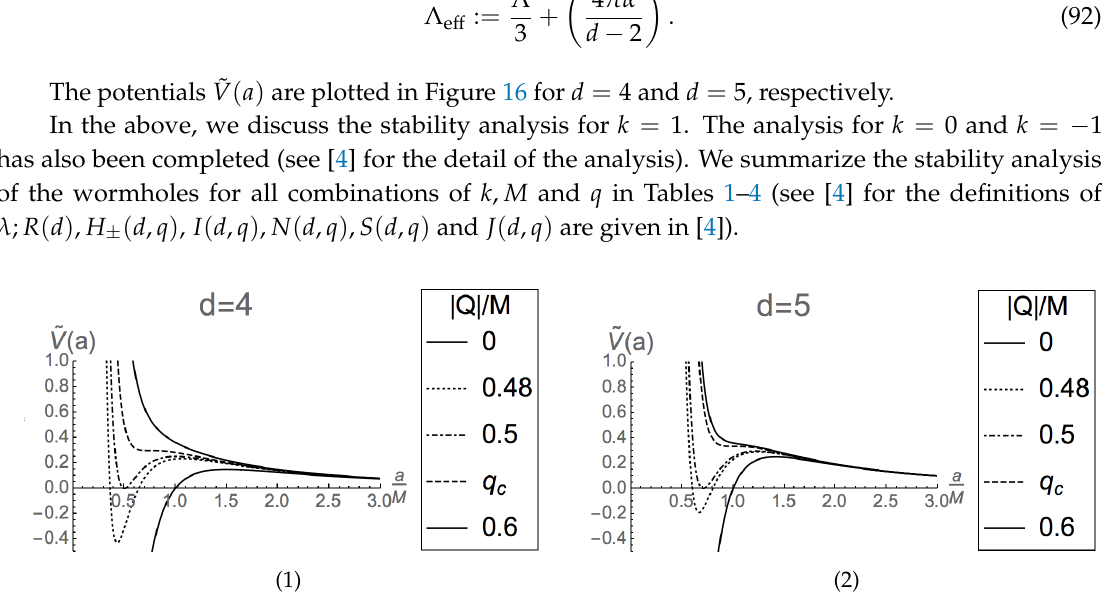
Figure 16. (1) The potential ˜ V ( a ) for d = 4, k = + 1 and M > 0. The dashed line is the potential for the